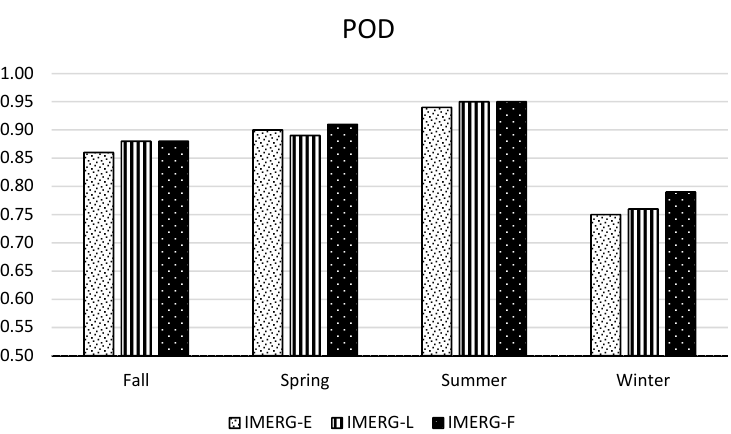
Figure 4. POD values for each season based on the seasonal evaluation.